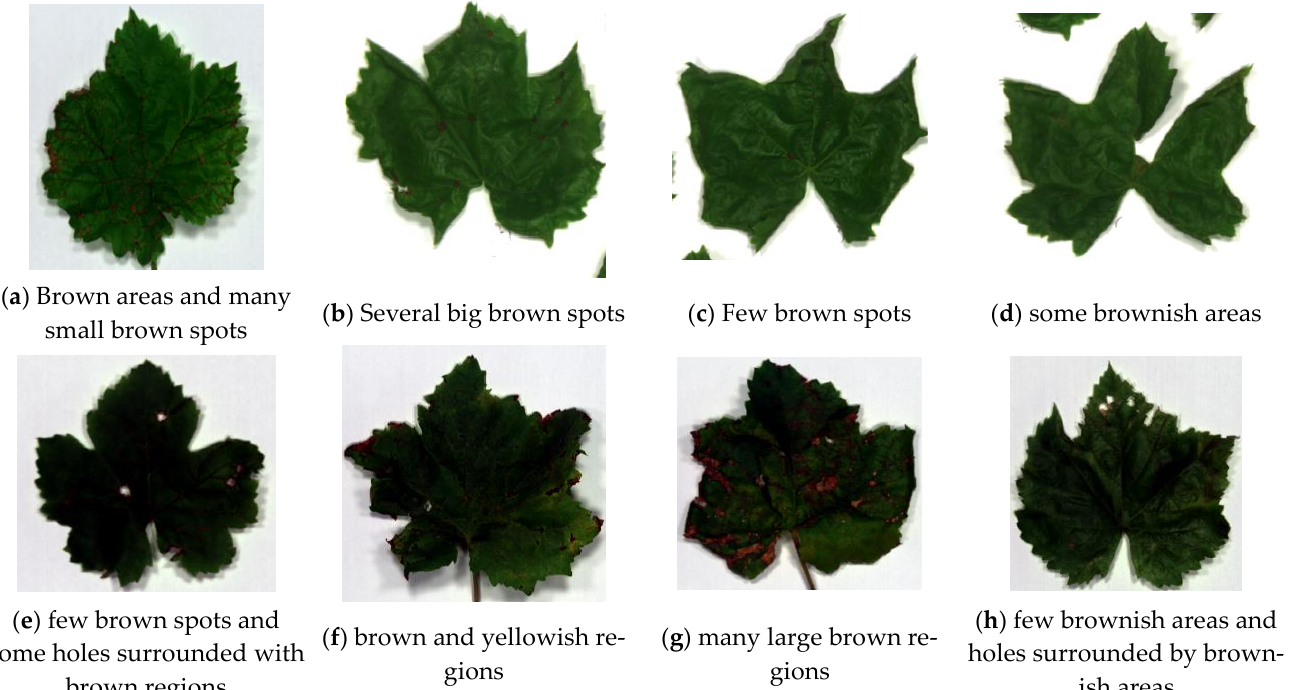
Figure 4. Sample of unhealthy leaves containing visible defects used for the study of visibly unhealthy leaves.